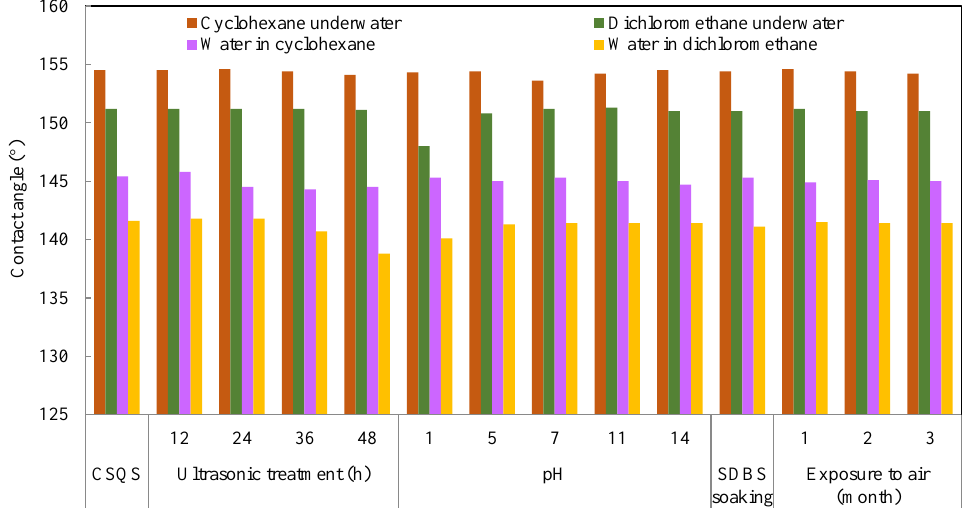
Figure 14. The contact angle of CSQS after ultrasonic treatment, sodium dodecylbenzene sulfonate cleaning, soaking.